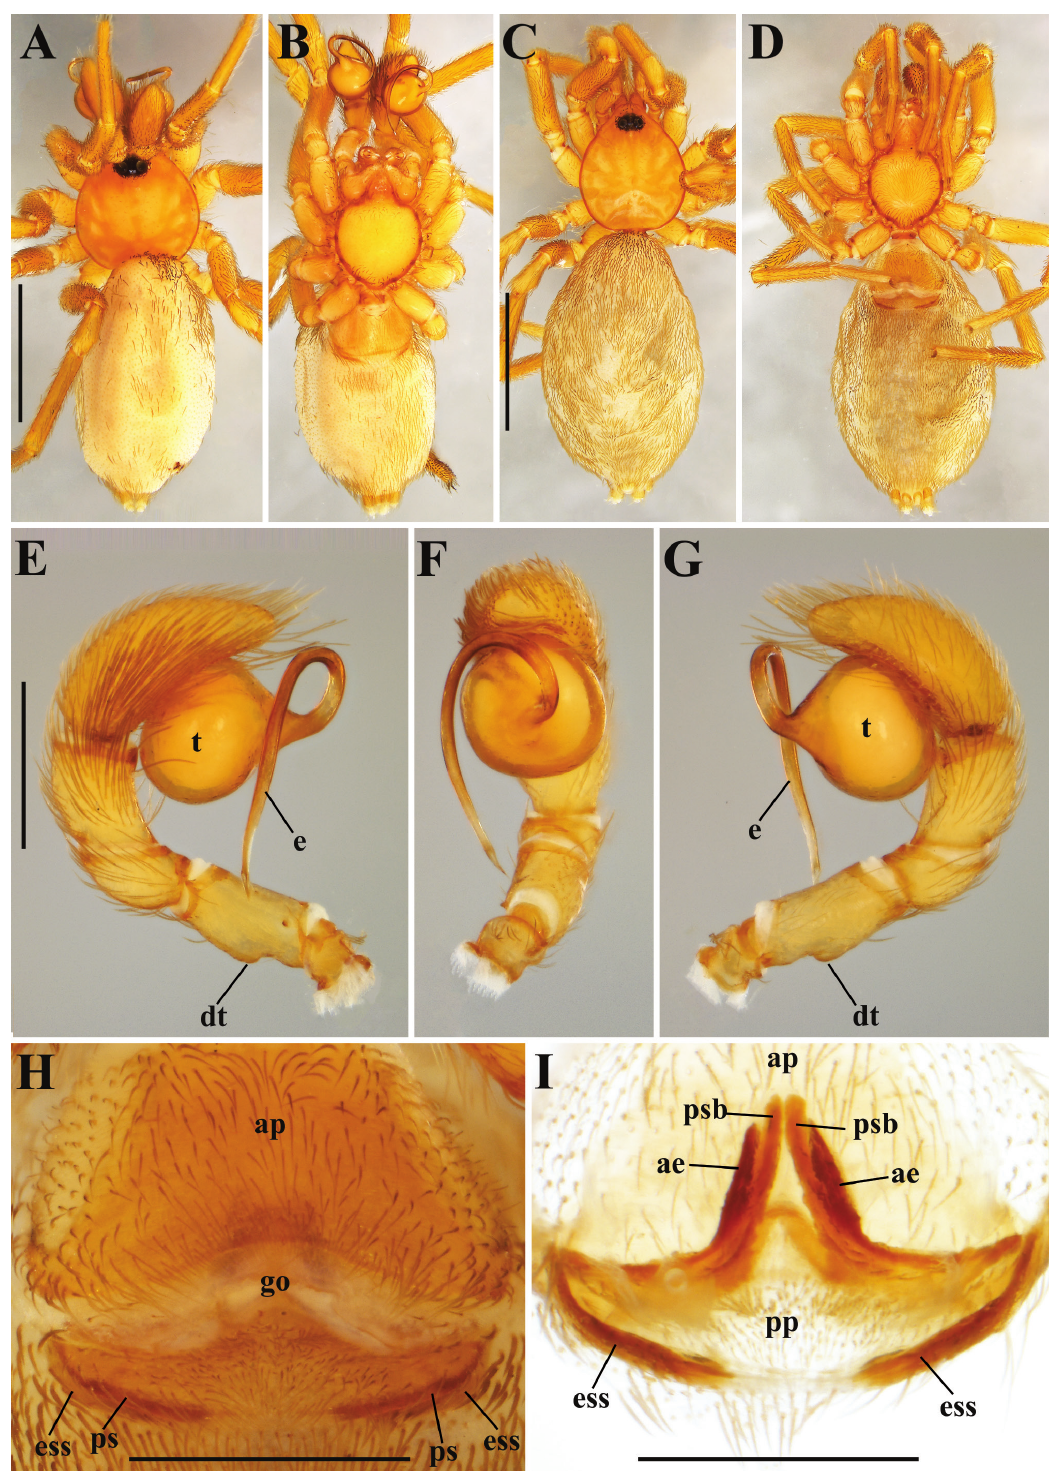
Fig. 1. Caponina alejandroi sp. nov. A – B , E – G . ♂, holotype (IAvH-I 3747). C – D , H – I . ♀, paratype (IAvH-I 3749). A . Habitus, dorsal view. B . Habitus, ventral view. C . Habitus, dorsal view. D . Habitus, ventral view. E . Left palp, retrolateral view. F . Left palp, ventral view. G . Left palp, prolateral view. H . External genitalia, ventral view. I . Internal genitalia, dorsal view. Scale bars: A–D = 1.5 mm; E–G = 1 mm; H–I = 0.5 mm. Abbreviations: see Material and